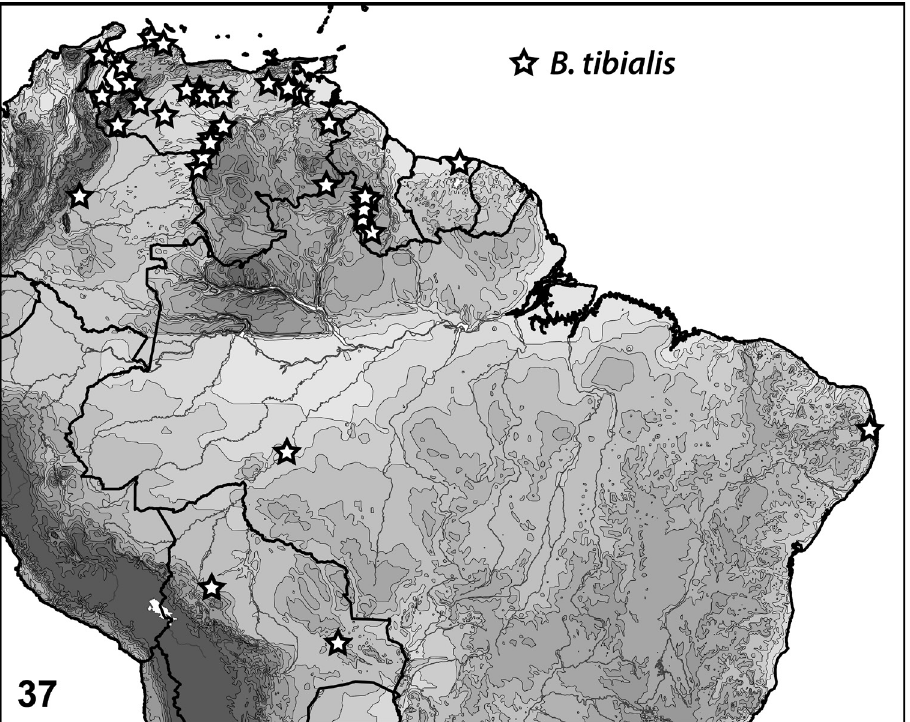
Figure 37. Bidessonotus species, South American